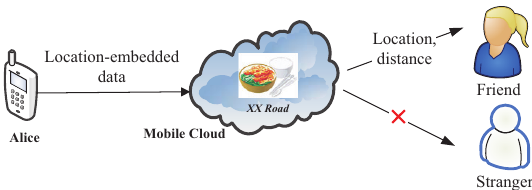
Figure 1. An example in which Alice shares location-embedded data with her